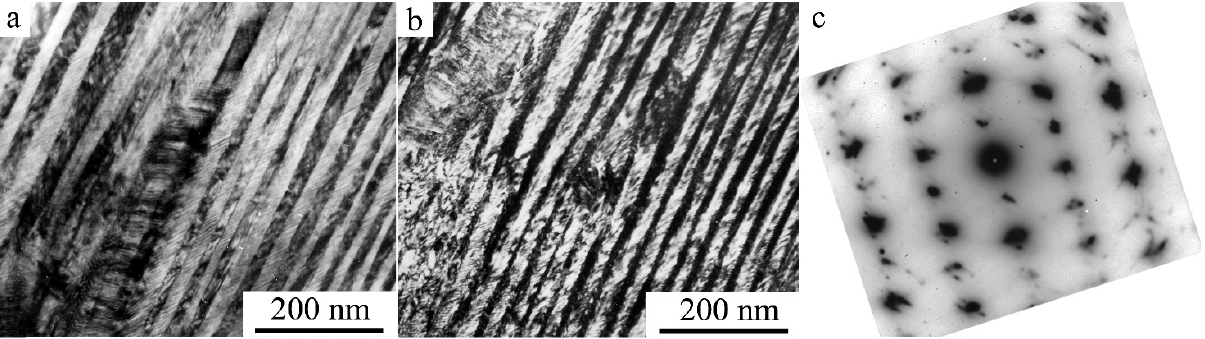
Figure 3. ( a ) Bright- and ( b ) dark-field TEM images of the B 19’ martensite microstructure and ( c ) the corresponding SAED pattern (z.a. [110] B 19’ ) of the Ti 49.4 Ni 50.6 quenched alloy [72].